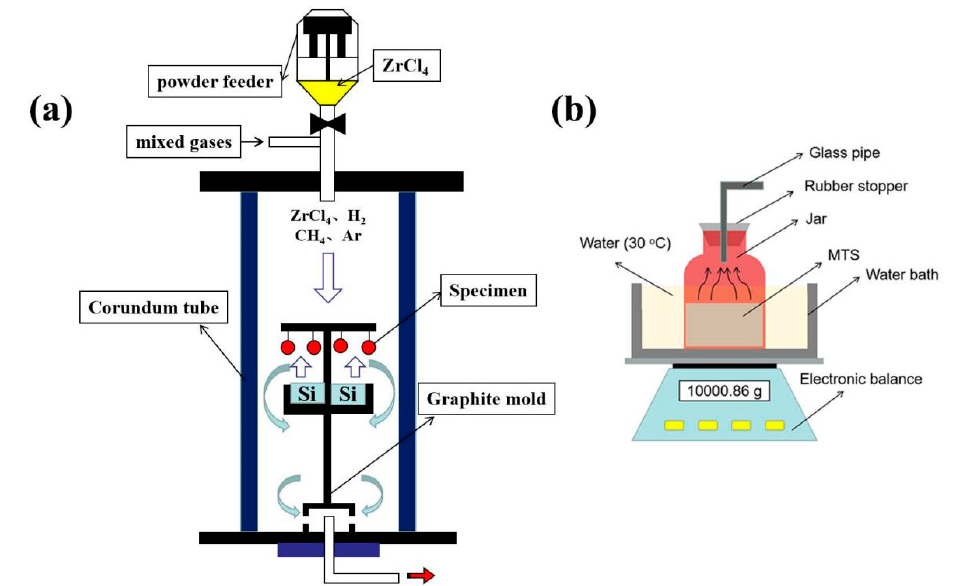
Figure 1. The schematic sketches of ZrC-SiC biphasic coating deposition equipment ( a ) and introducing method of methyltrichlorosilane (MTS) ( b ).